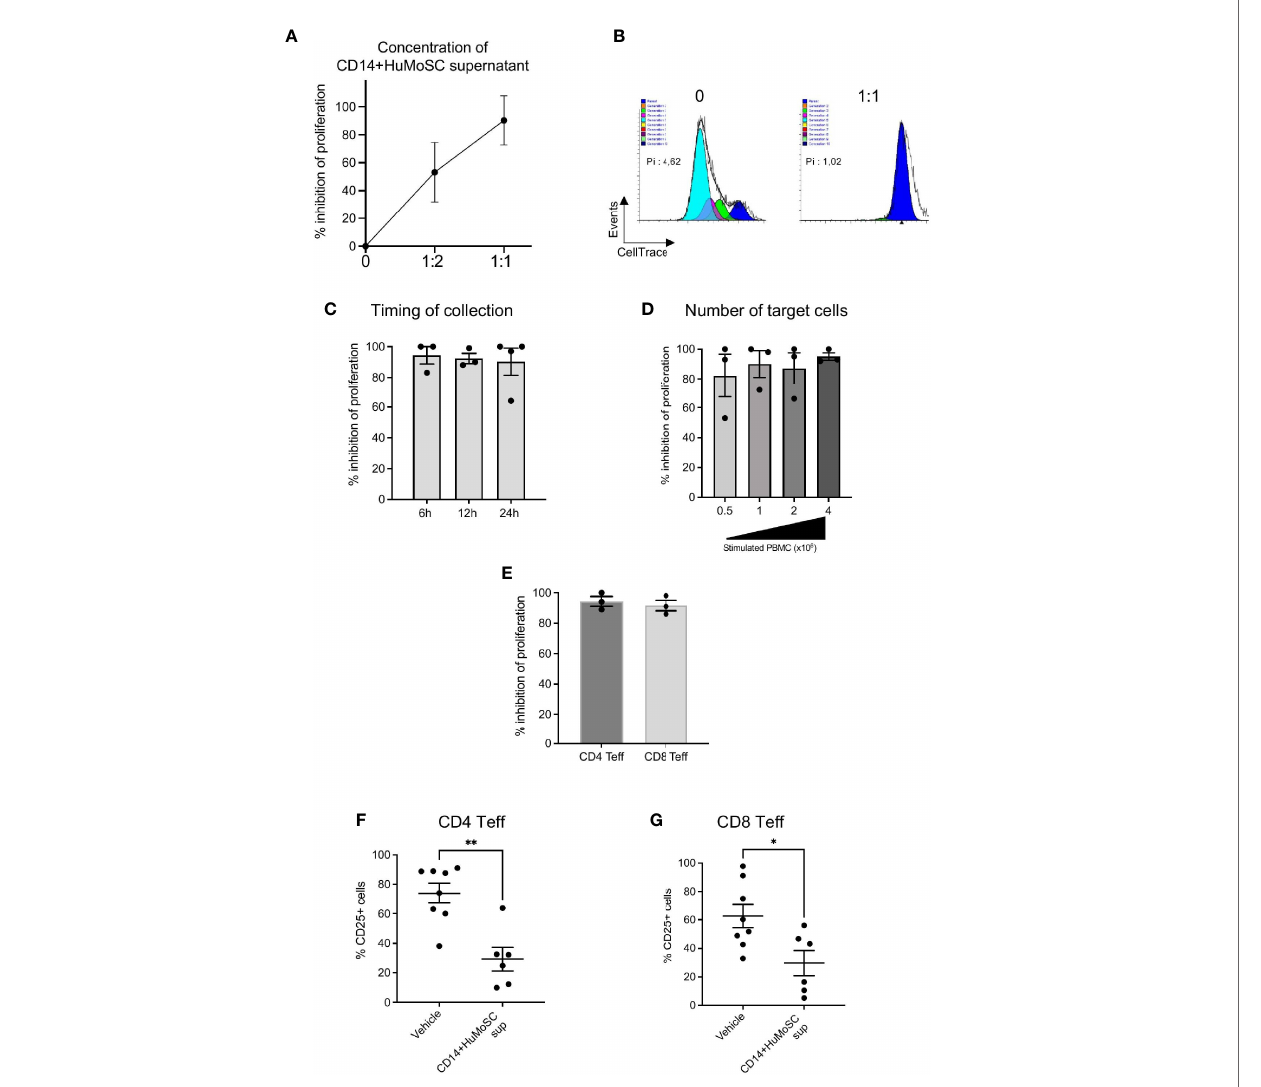
FIGURE 2 | Characterization of optimal production parameters to produce an immunosuppressive supernatant derived from CD14+HuMoSC. (A) Concentration: Cell- Trace Violet labeled PBMC stimulated with anti-CD3/CD28 microbeads were cultured in presence of CD14+HuMoSC supernatant. Three different ratios of supernatant volume were assessed- 0, 1:1 and 1:2 volume of supernatant/volume of culture medium. The proliferation index was determined after 4 days and the percentage of proliferation inhibition was calculated. Results of 3 independent experiments are shown. (B) Representative Mod fi t analysis is shown. Pi, proliferation index; %: inhibition of proliferation. (C) Time of collection: CD14+HuMoSC were plated for 6h, 12h and 24h at concentration of 1 million cells/mL in physiological saline. At the indicated time point, Cell-Trace Violet labeled PBMC stimulated with anti-CD3/CD28 microbeads were cultured in presence of CD14+HuMoSC supernatant. The proliferation index was determined after 4 days and the percentage of proliferation inhibition was calculated. Results of 3 independent experiments are shown. (D) 500 000, 1 million, 2 million and 4 million of PBMC stimulated by anti-CD3/CD28 microbeads for 4 days were treated with CD14+HuMoSC supernatant, and PBMC proliferation was analyzed. Results of 3 independent experiments. (E) PBMC were stimulated with anti-CD3/CD28 microbeads for 4 days with or without CD14+HuMoSC supernatant Percentage of T cell proliferation inhibition was determined separately for CD4+ and CD8+ T lymphocytes by fl ow cytometry. Results of 4 independent experiments are shown. (F, G) . CD25 expression on CD4+ and CD8+ T cells stimulated by anti-CD3/CD28 microbeads for 4 days with or without CD14+HuMoSC supernatant. Results of 6 independent experiments. Data are shown as mean ± SEM of representative experiments. Two-tailed Mann Whitney test: *p < 0.05, **p <